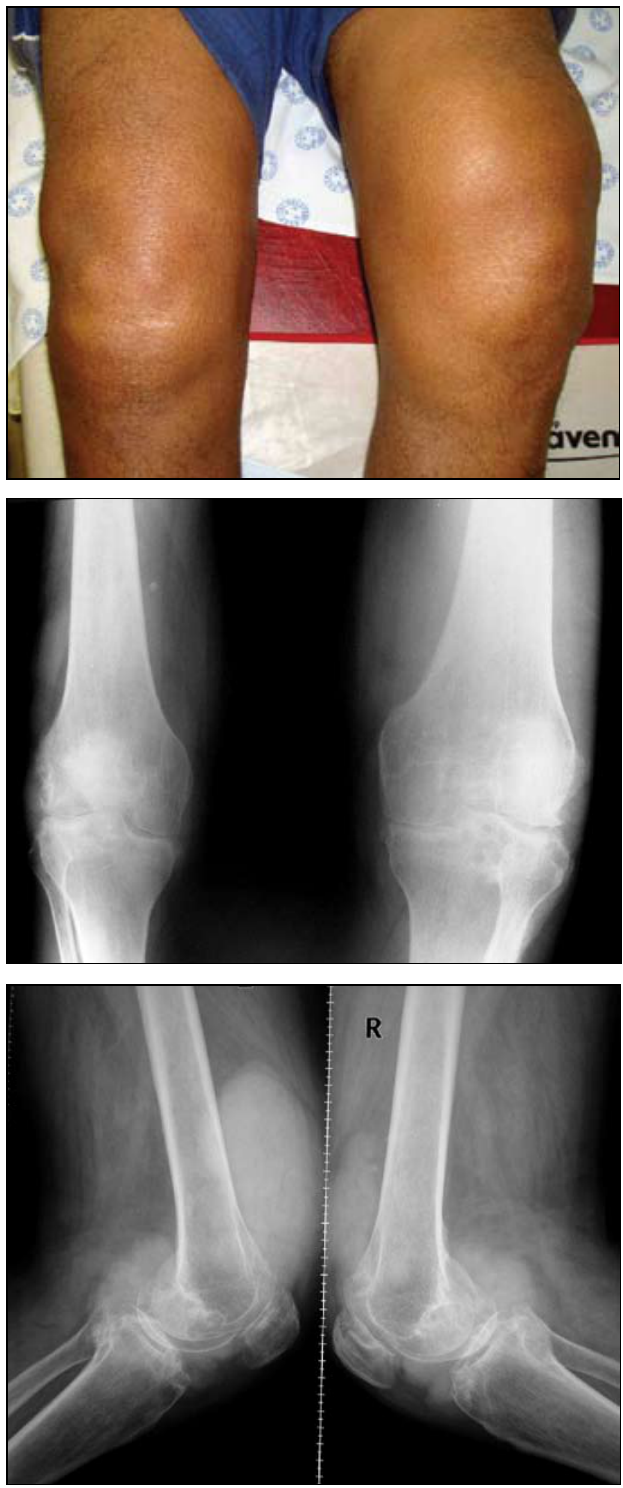
Fig. 4. Photograph of both knees shows extensive tophi. Accompanying anteroposterior and lateral radiographs show dense soft-tissue swelling around the joint, with extension into the supra and infra patella bursae and posterior aspect of the joint. Also note typical gouty